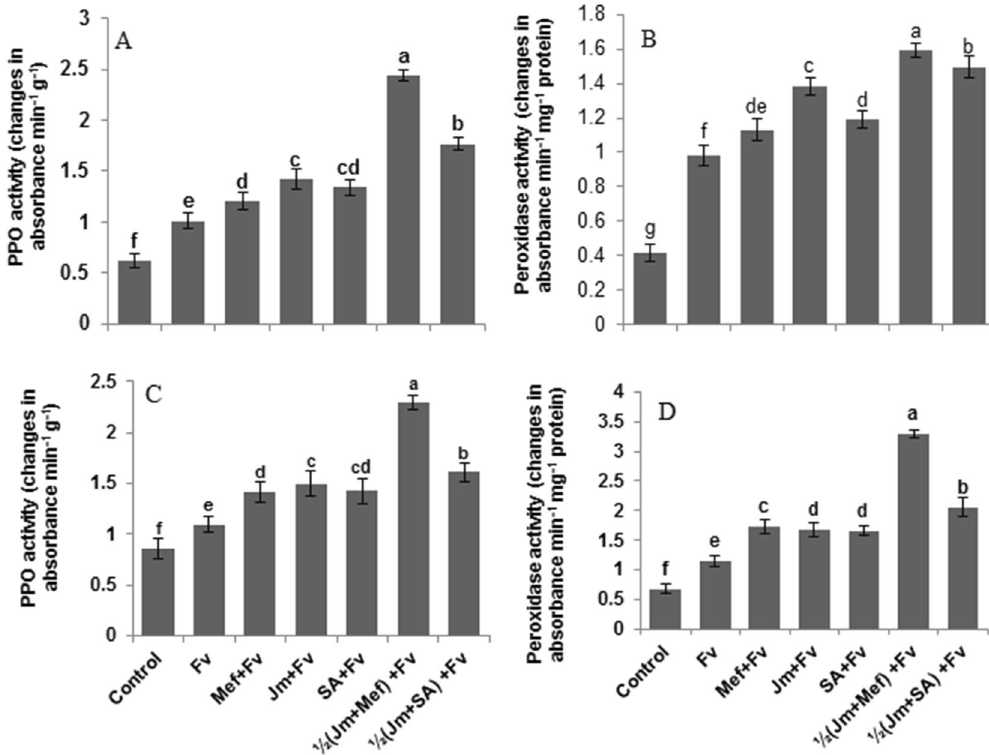
Figure 7. Effect of seed treatments with J. mimosifolia extract and control formulations on PPO and peroxidase activities of maize leaves from plants inoculated with F. verticillioides (21 d after inoculation). ( A ) PPO activity (pot experiment), ( B ) Peroxidase activity (pot experiment), ( C ) PPO activity (field experiment), ( D ) Peroxidase activity (field experiment). Data are expressed as ± standard deviation of mean (SD) of three replicates. Mean values with different letters are significantly different from each other according to the least significant difference ( LSD ) at P < 0.05. See Table 1 for